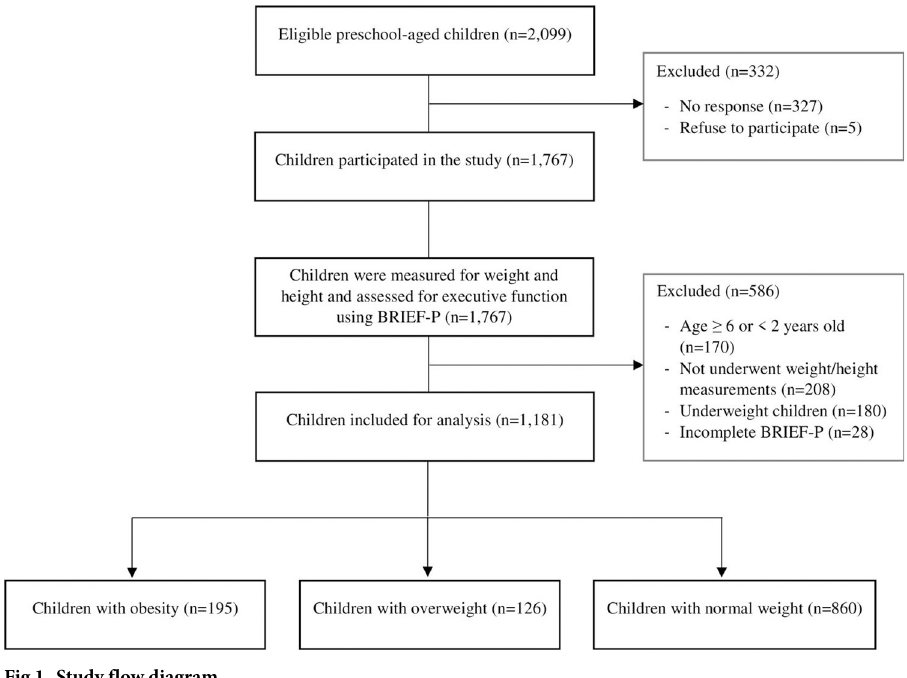
Fig 1. Study flow